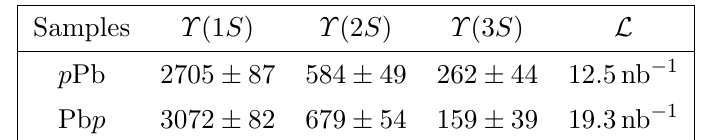
Table 1 . Yields of (cid:7) (1 S ), (cid:7) (2 S ), (cid:7) (3 S ) mesons in p Pb and Pb p samples as given by the (cid:12)t. The uncertainties are statistical